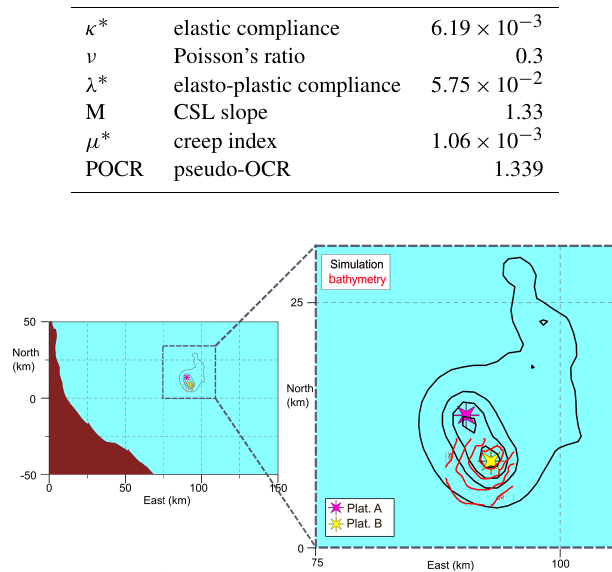
Figure 4. Subsidence developed in the 7 year time interval elapsed between two bathymetric surveys, perfomed at year 3 and 10 af- ter the production start. Comparison between corresponding iso- subsidence lines: model estimates versus survey